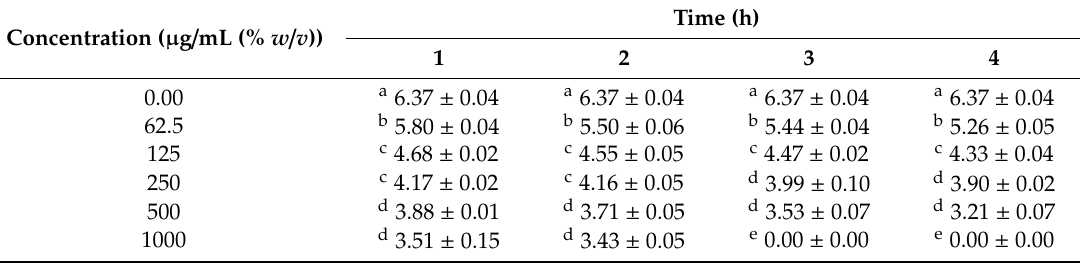
Table 6. The sporicidal activity of β -asarone against spores of B. megaterium ATTC14581. Concentration ( µ g / mL (% w / v ))